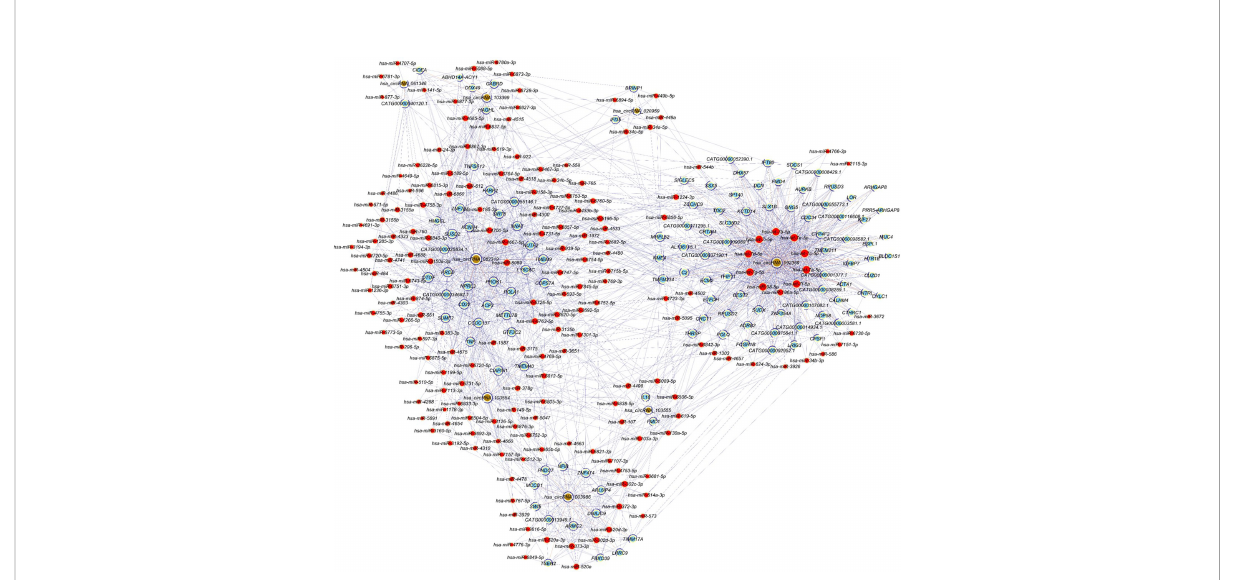
FIGURE 5 CircRNA-miRNA-mRNA regulatory network. Red nodes represent miRNAs, light-blue nodes represent target genes, and brown nodes represent circRNAs. Edges with T-shape arrow and edges without arrow represent directed and undirect relationships,